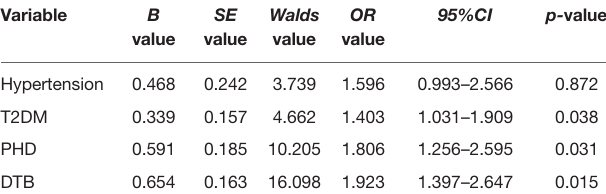
TABLE 5 | Multivariate analysis of IRI in patients with